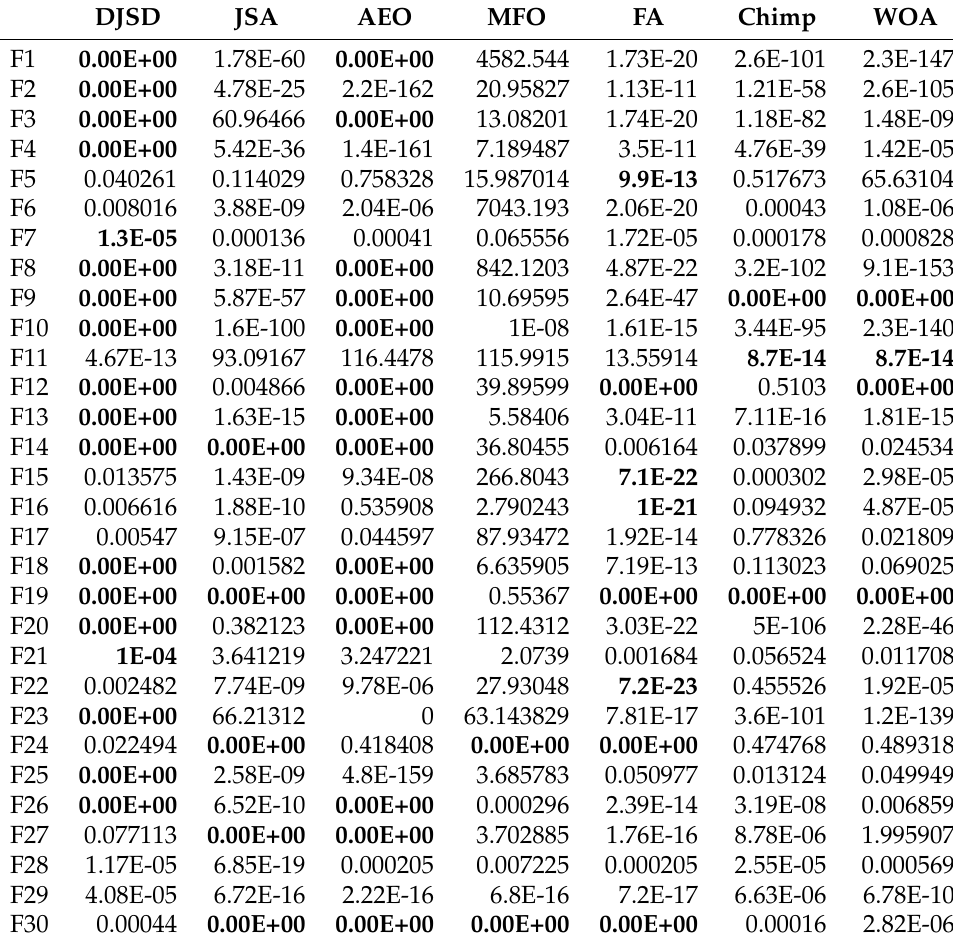
Table 4. Standard deviation (STD) of fitness value obtained by each algorithm.